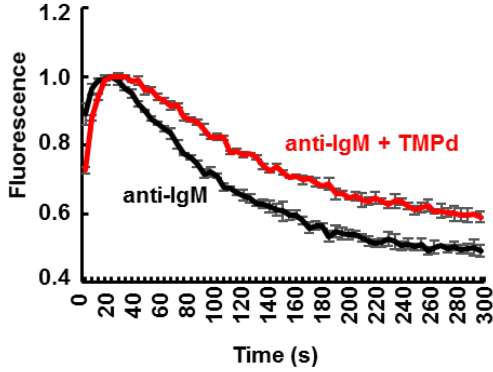
Figure 7. The trimethoprim (TMP) dimer enhances the duration of calcium mobilization. SYK-deficient DT40 cells stably expressing Myc-SYK-eDHFR and labeled with Fluo-4 were activated by anti-IgM in the absence or presence of the TMP dimer (TMPd). Fluorescence readings were obtained every 5 s. Data represent means ± standard error of the mean (SEM) of triplicate experiments repeated three times.